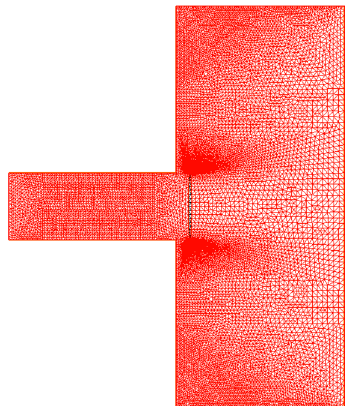
Figure 4. Case b: valve operative condition with h = 10 mm, numerical model mesh for the scheme reported in Figure 2.